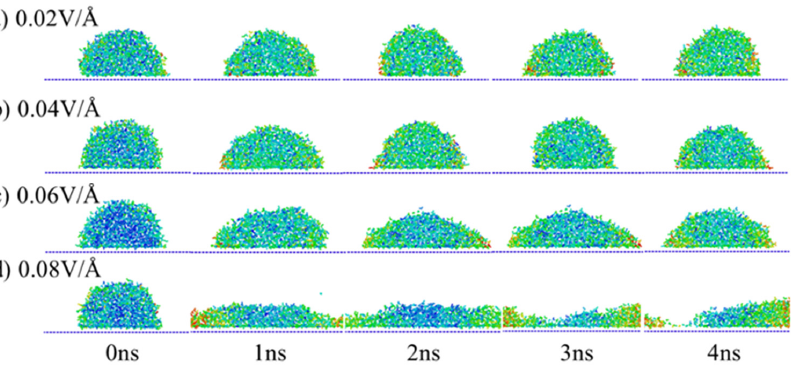
Figure 5. Displacement distribution under different electric field. ( a ) 0.02 V/A, ( b ) 0.04 V/A, ( c ) 0.06 V/A, ( d ) 0.08 V/A.